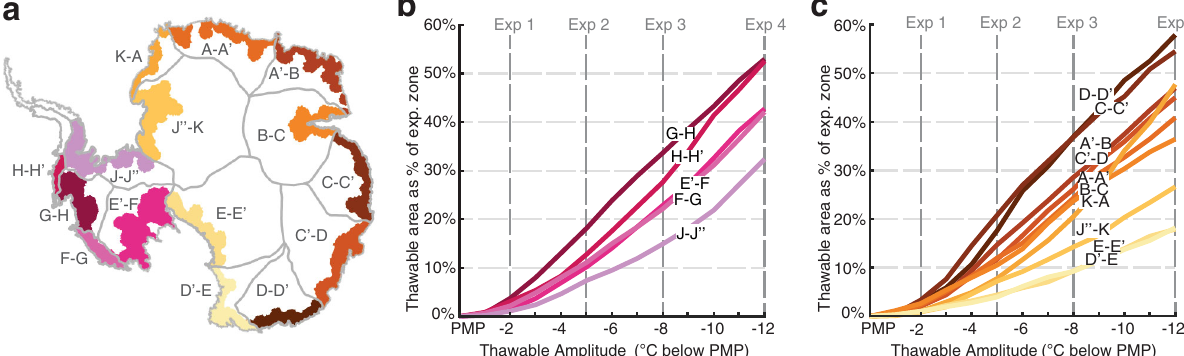
Fig. 5 | Percentage of thawable area within each drainage basin experiment zone. a Map of each basin experiment zone with darker shaded regions indicating basins with a larger spatial extent of thawable area. West and East Antarctic basins are marked with different color scales (pink and orange, respectively). Percentage